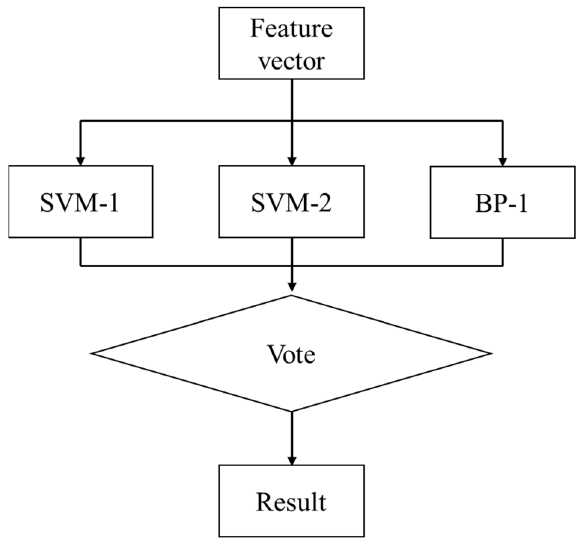
Figure 8. Diagram of integrated model.